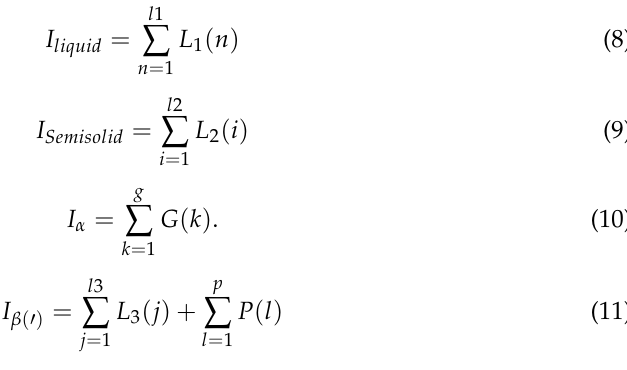
Table 3. Parameter values used for the Trezza model (Equation (7)) based on Trezza et al. [18]. Range of Investigated Spacing Number of Parameter Values